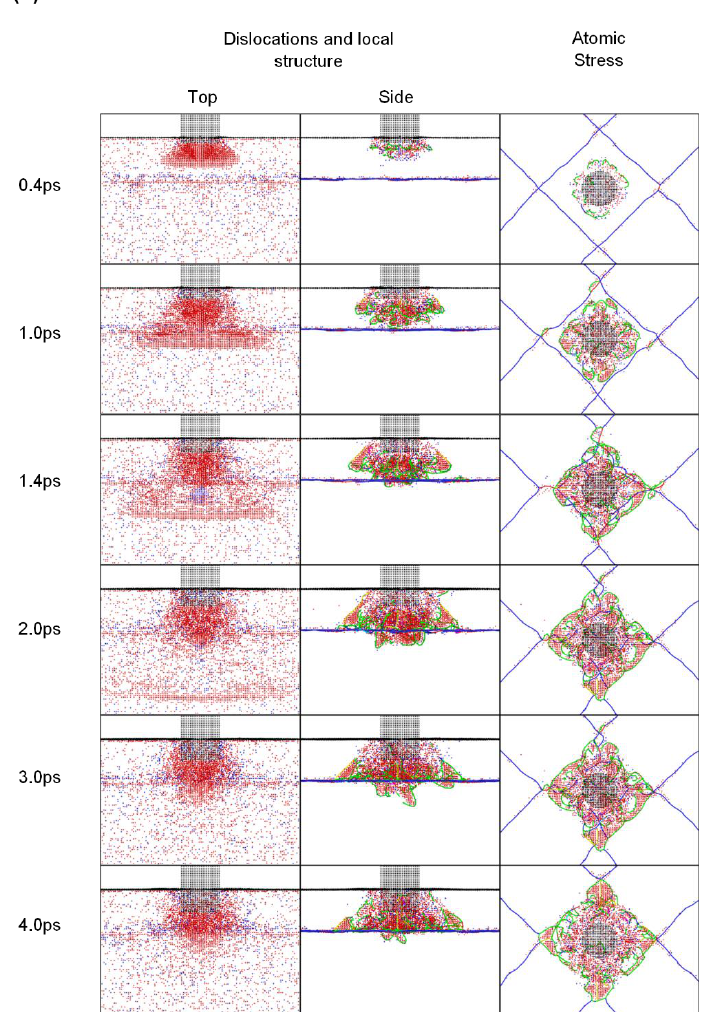
Figure 2. Simulation snapshots illustrating the local structure and line dislocations for the top and side views and the atomic stress for the side view for an initial impactor velocity of ( a ) 0.5 km/s and ( b ) 1.5 km/s. Note that images are zoomed in to the region of interest and do not show the entire system Atoms of the impactor and top surface are shown in black. Dislocation and local structure visualization includes both line dislocations (shown as smooth lines colored according to the key) and bulk atoms with a local structure other than FCC or uncategorized (shown as points colored according to the key). For stress visualization, only atoms with atomic stress normal to the plane of impact such that |S z | > 1.3 × 10 −1 9 Pa∙m 3 are visualized.